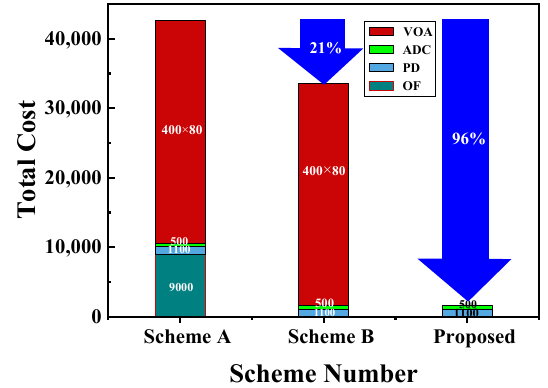
Figure 3. CAPEX comparison of three schemes.